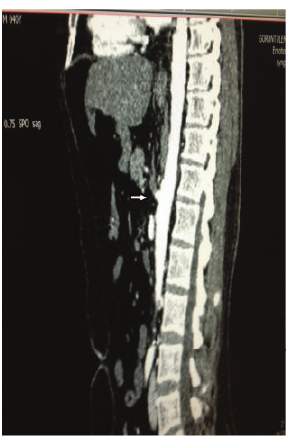
Figure 1: Lateral reconstruction of a contrast-enhanced CT of the abdomen demonstrates occlusion of the CA with visible stump (arrow).